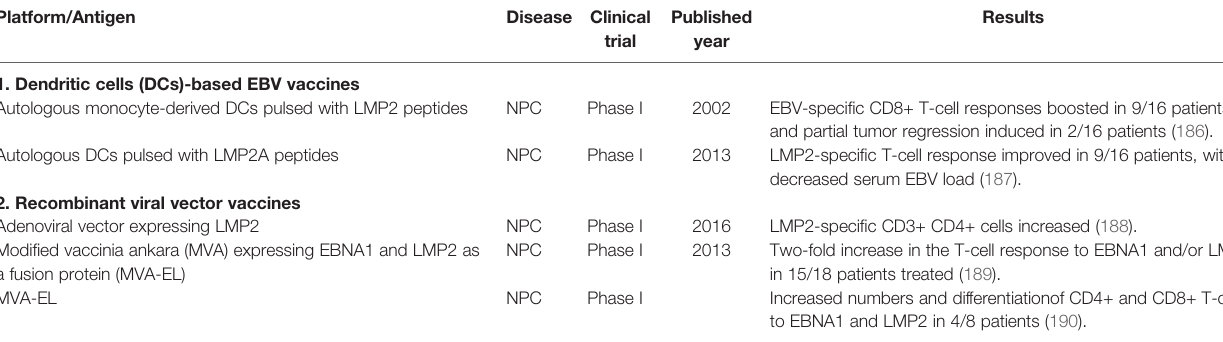
TABLE 2 | Summary of therapeutic EBV